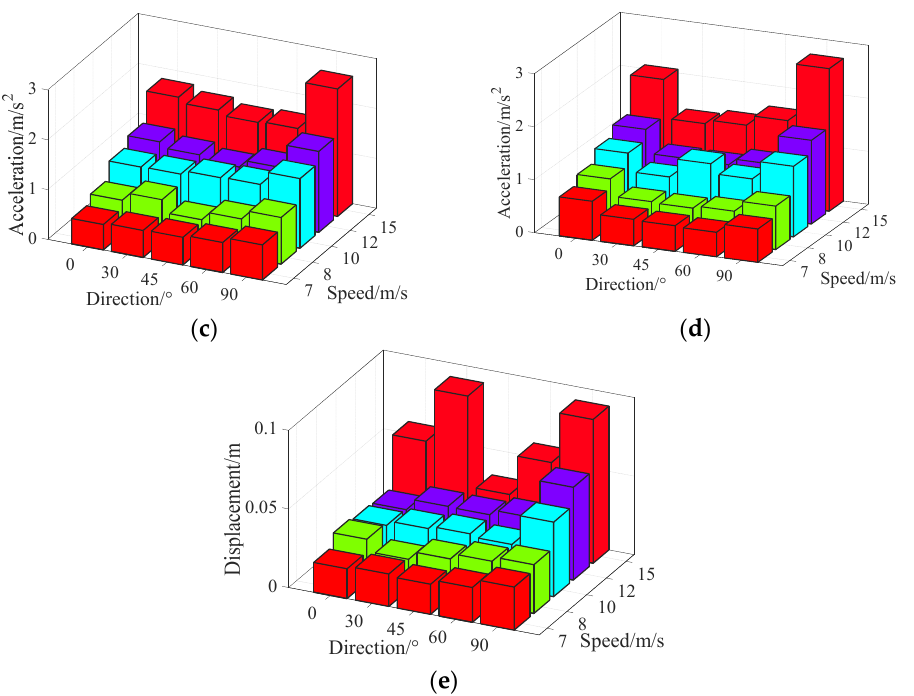
Figure 16. The results in the steady wind test: ( a ) Sensor 1; ( b ) Sensor 2; ( c ) Sensor 3; ( d ) Sensor 4; ( e ) Sensor 5.